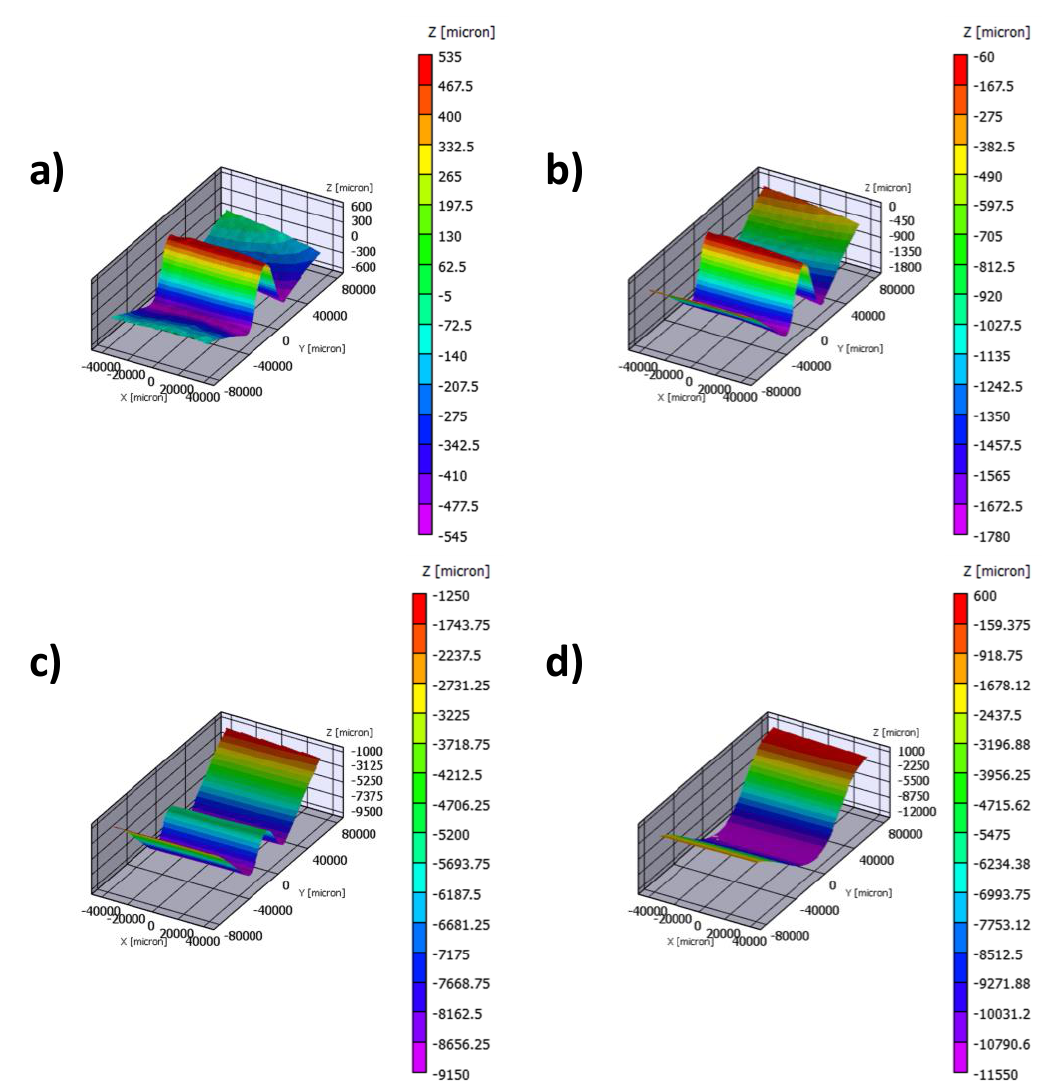
Figure 20. DIC out-of-plane displacement contour plot (MFB#3 sample) at ( a ) delamination buckling onset, ( b ) delamination growth initiation, ( c ) global buckling and ( d ) snap-trough phenomenon.